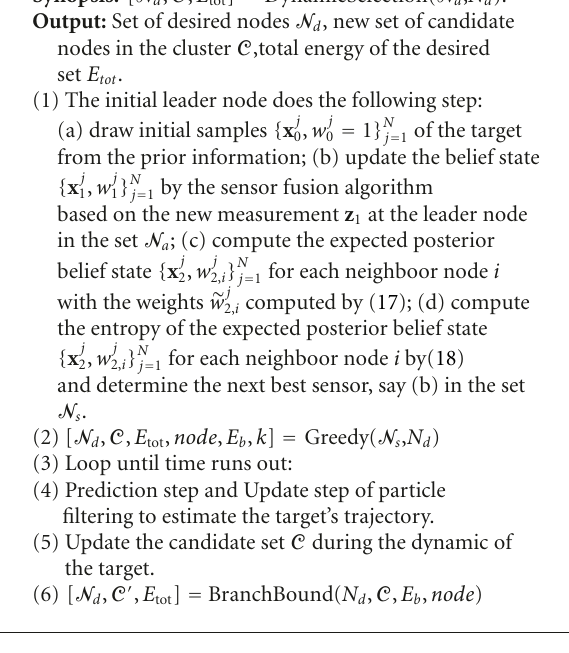
Algorithm 3: Tracking algorithm.